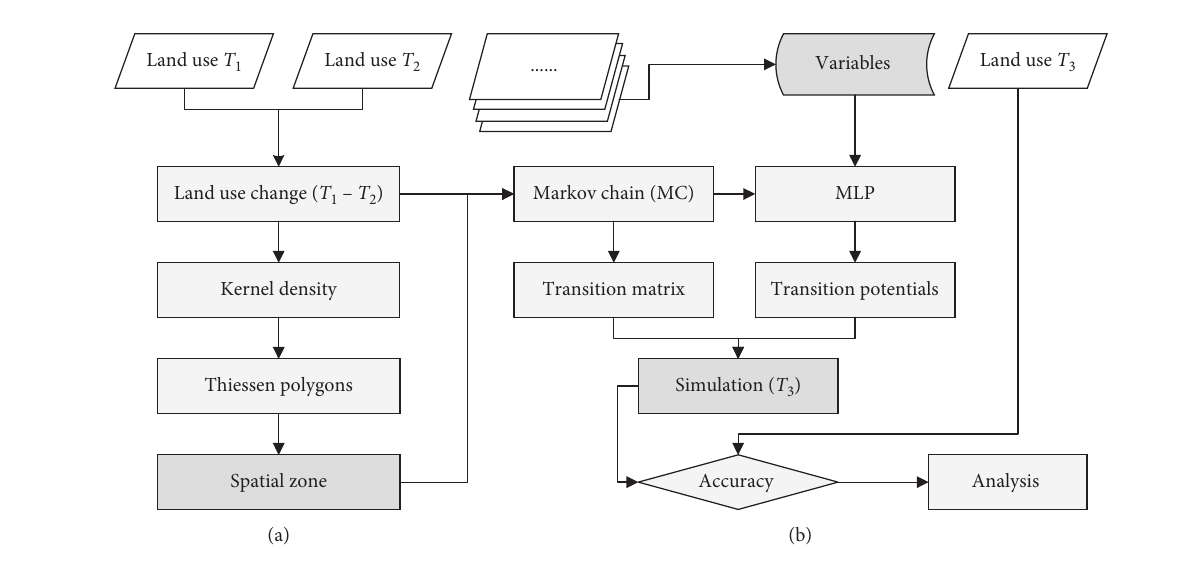
Figure 2: Land use simulation process. (a) Spatial zone. (b) MLP-MC. Table 1: Data source and